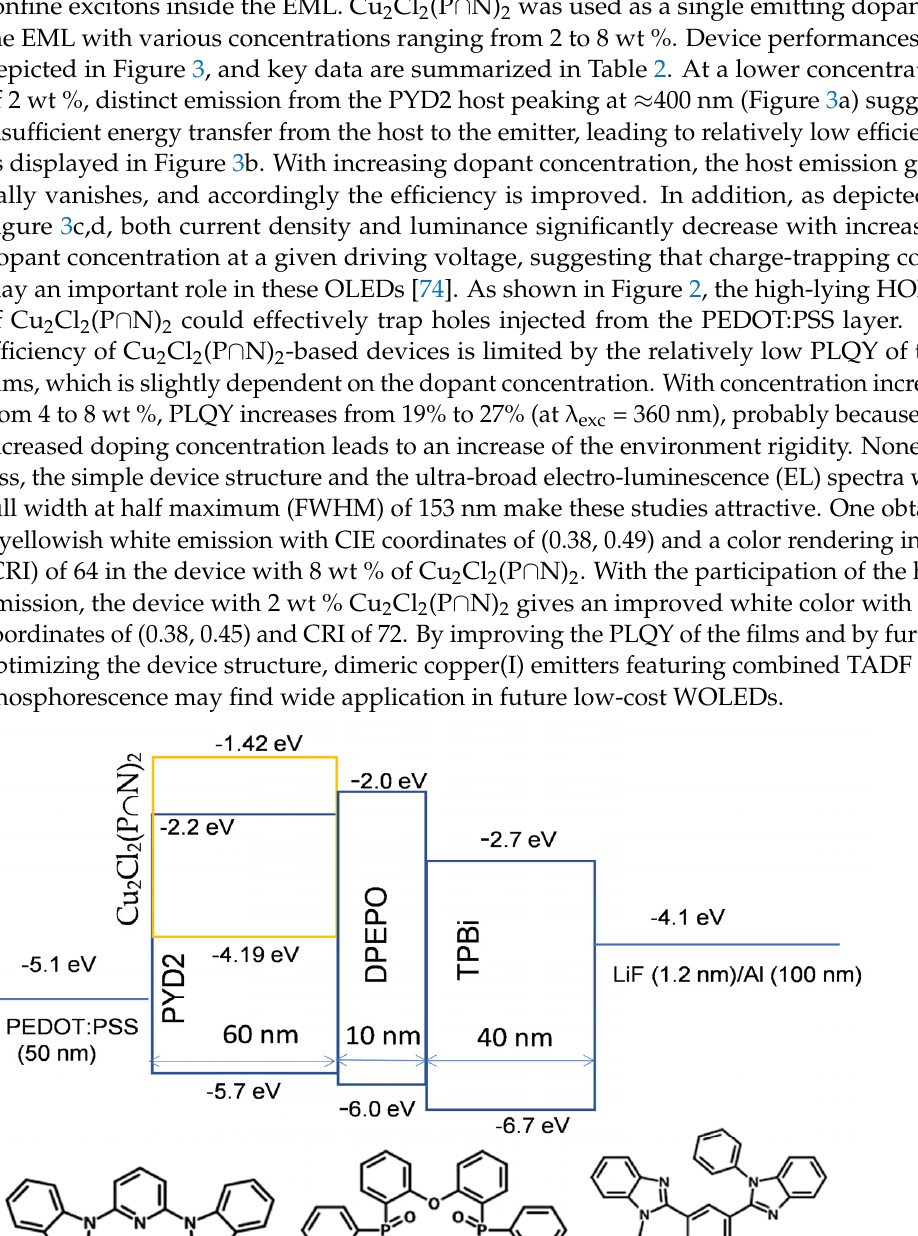
Figure 2. Schematic diagram of the OLEDs, showing the respective energy levels, layer thicknesses, and chemical structures of the organic materials used for the device. The energy levels of Cu 2 Cl 2 (P ∩ N) 2 were measured by an electrochemical method and those of other materials were extracted from the literature [72,73,75–77].